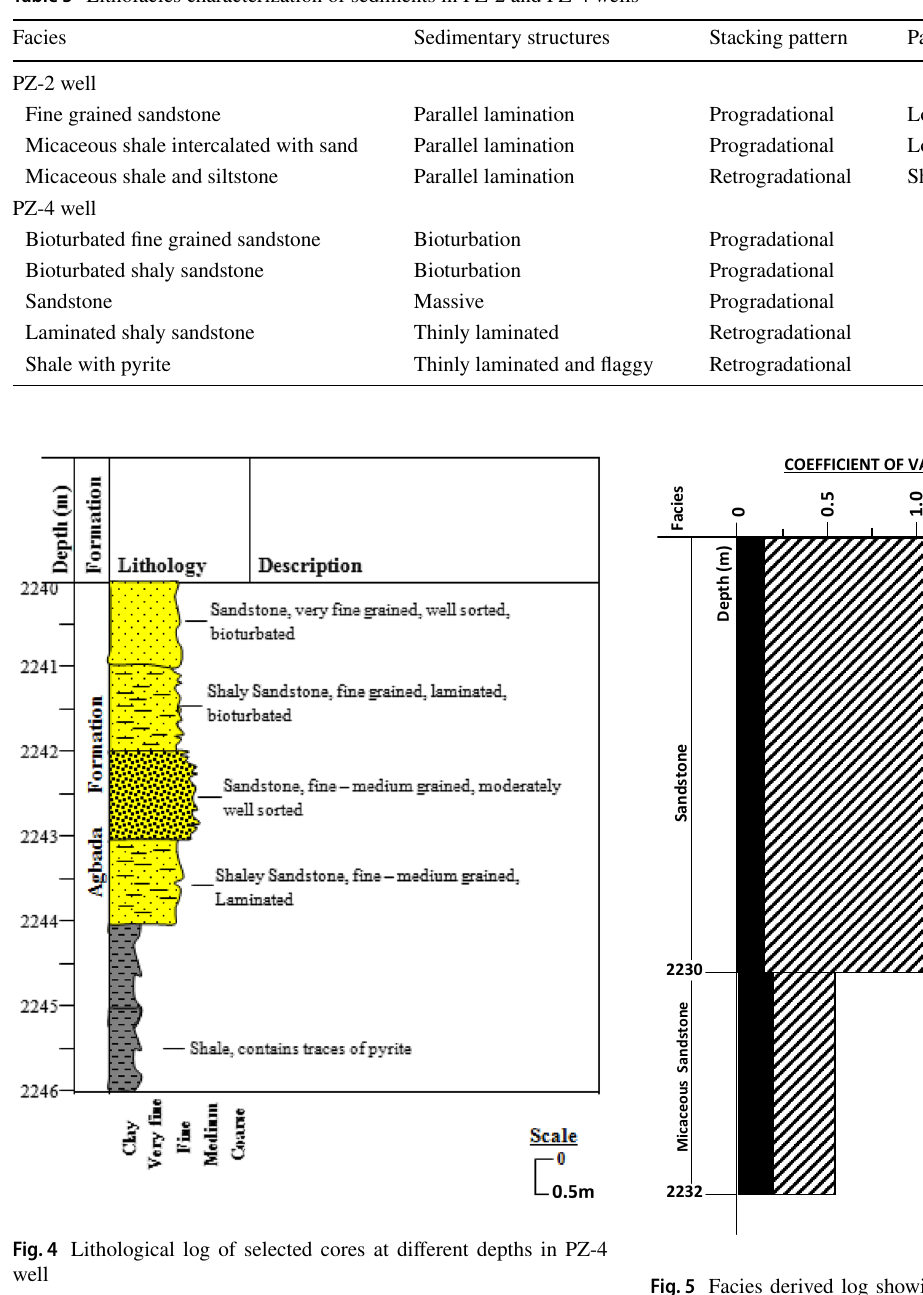
Facies derived log showing changes of coefficient of porosity and permeability variation in PZ-2